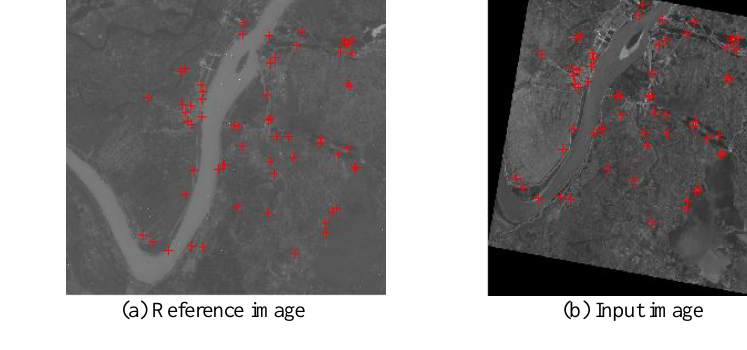
Figure 4: Image registration from test set 1